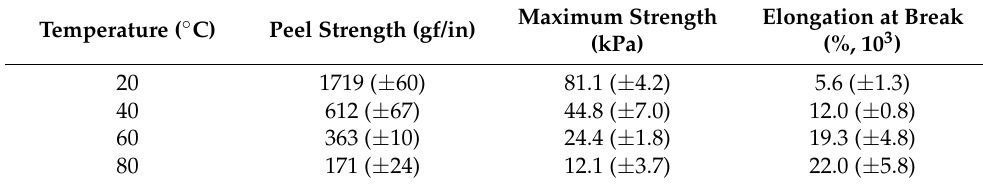
Table 1. The peel strength and mechanical properties of h-PSA at different temperatures. Maximum Temperature ( ◦ C) Peel Strength (gf/in)